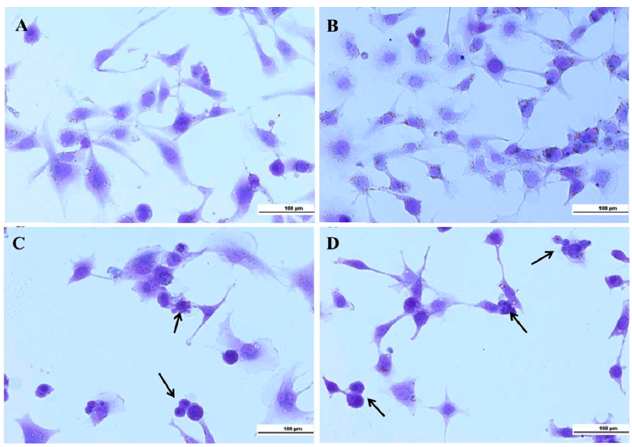
Figure 6. Crystal violet shows morphological characterization: ( A ) control HLF; ( B ) free HPLPNCs; ( C ) free BrPA; and ( D ) encapsulated BrPA. Arrows indicate apoptotic cells.